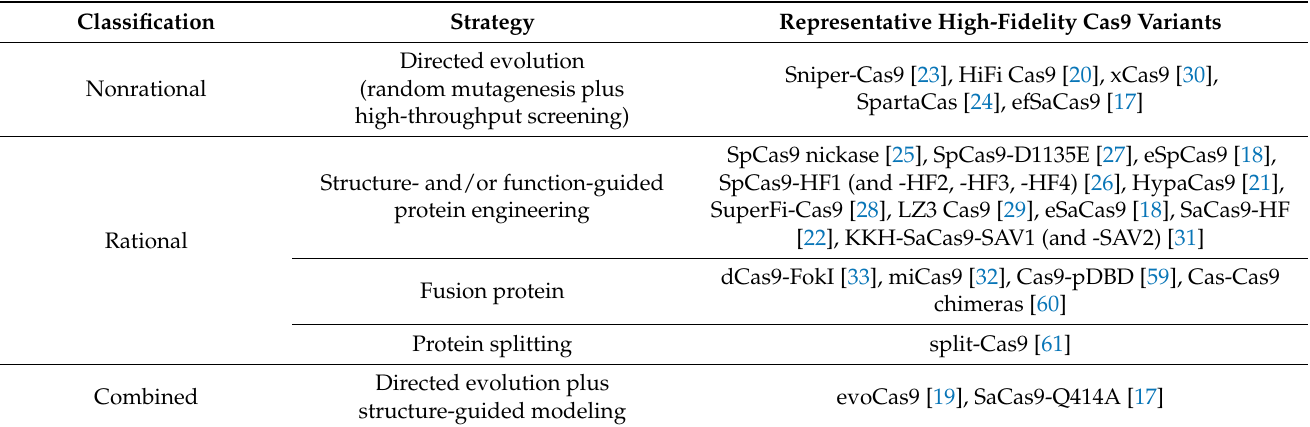
Table 1. Strategies for engineering high-fidelity Cas9 proteins and representative